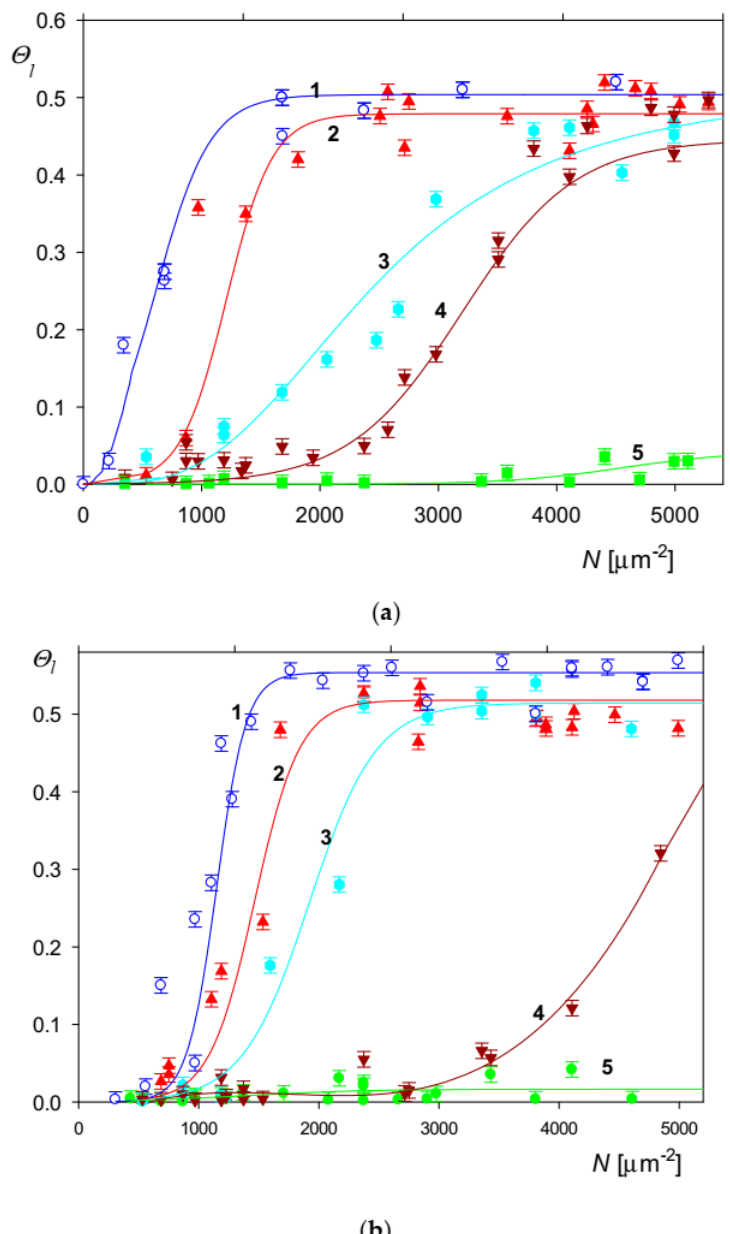
Figure 8. The dependence of the maximum coverage of microparticles on the HSA layers of various surface concentration determined by optical microscopy and AFM imaging. The points denote the experimental data obtained for various ionic strengths of the particle suspension: (1) ( ○ ) 0.15 M; (2) ( ▲ ), 0.05 M; (3) ( ), 0.04 M; (4) ( ) 0.03 M; (5) ( ■ ) 0.02 M. The solid lines are fits of experimental data. Part ( a ), pH 5.5; part ( b ), pH 7.4 (PBS).